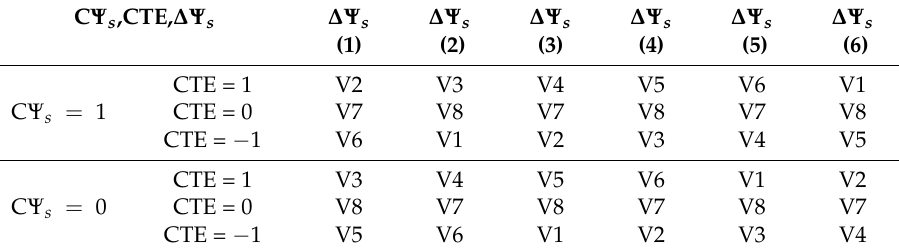
Table 2. DTC logic switching